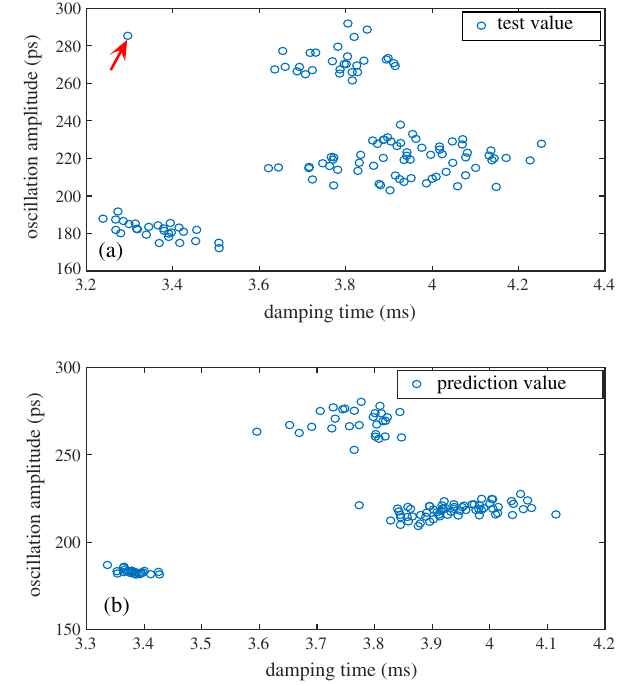
FIG. 7. The distribution of results. (a) results obtained by traditional method; (b) results obtained by CNN model.